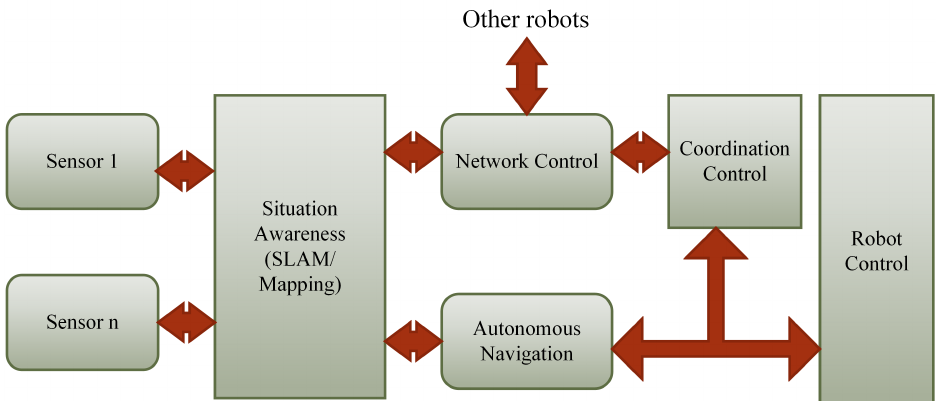
Figure 1. Simplified block diagram of the software system of the deployment control approach. The proposed algorithm is implemented on the coordination control and navigation